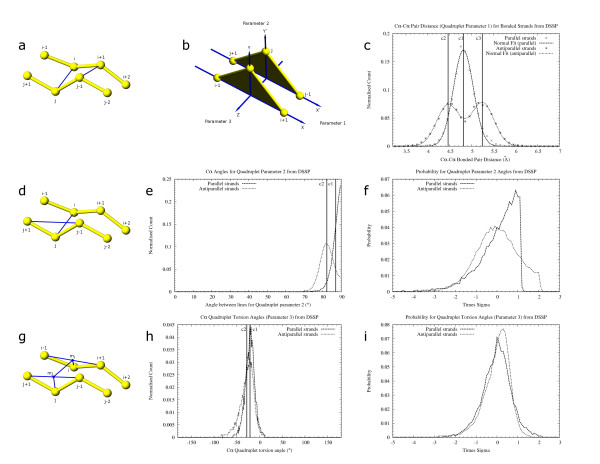
The three parameters on which quadruplets scoring is based. In figs. a, d, g, a quadruplet is formed from residues i, i+1, j-1 and j. The score is used to select the best quadruplets to join and form β-sheets. Each scoring parameter has been chosen such that they least influence each other. Residues i-1, i+2, j+1 and j-2 are required to calculate angles for quadruplet scoring. The first parameter is Cα-Cα distance between paired residues (fig. a). Blue lines joining i, j and i+1, j-1 show the distance being scored. This parameter approximates the deviation of the triangle apex i with reference to the triangle apex j in fig. b due to rotation of the plane i-1, i, i+1 on the X axis. Fig. c shows the Cα-Cα distances for parallel and antiparallel β-strands obtained from DSSP [8] output. Data is binned at 0.1 Å intervals and fit to a normal distribution using "gnuplot" [40]. Distribution for parallel β-strands has a mean at c1 (4.81 Å) with a sigma of 0.22. Distance for antiparallel β-strands follows a bi-modal distribution with means (μ) at c2 (4.46 Å) and c3(5.24 Å) and a standard deviation (σ) of 0.26. These μ and σ values were used to calculate the probability of occurrence of Cα-Cα pairing distances while scoring quadruplets by our algorithm. A Cα-Cα maximum distance of 7.5 Å (not shown) was used to limit pairing between residues. The second parameter is angle between lines (shown in blue) joining the vertices i, j and the base j-1, j+1 of the imaginary triangles j-1, j, j+1 and i+1, i, i-1 (fig. d). Only one of the four cases is shown. The other angles are between lines j, i and i+1, i-1; j-1, i+1 and i, i+2; i+1, j-1 and j, j-2. Deviation of this angle approximates the deviation of the triangle apex i-1 with reference to the triangle apex j+1 in fig. b due to rotation of the plane i-1, i, i+1 on the Y axis. Fig. e shows the distribution of angles, binned at 5° intervals, obtained from parallel and antiparallel β-strands defined by DSSP where c1 (87°) and c2 (82.2°) are the respective means. Fig. f shows the probability of obtaining a parameter-2 angle at different multipliers of the standard deviation for data shown in fig. e. The probability obtained is used for scoring quadruplets. The third parameter is a torsion angle (fig. g) between the points j, mj, mi, i. mj is the midpoint between j+i, j-1. mi is the midpoint between i-1, i+1. Lines joining residues and the midpoints are shown in blue. A similar torsion angle involving residues j-1, i+1 as end points and midpoints between j, j-2 and i, i+2 is computed (not shown). Deviation of the torsion angle approximates the deviation of vertex i in fig. b with respect to vertex j due to rotation of the plane i-1, i, i+1 on the Z axis. Fig. h shows the distribution of torsion angles (binned at 5° intervals) obtained from DSSP output where c1 (-20.9) and c2 (-27.9) are the respective means for data from parallel and antiparallel β-strands. Fig. i shows the probability of obtaining a torsion angle at different multipliers of the standard deviation for the data in fig. h.